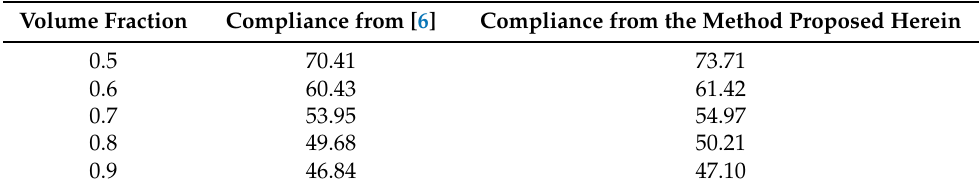
Table 1. Cantilever beam compliance for different volume fractions from the literature and the method proposed herein Volume